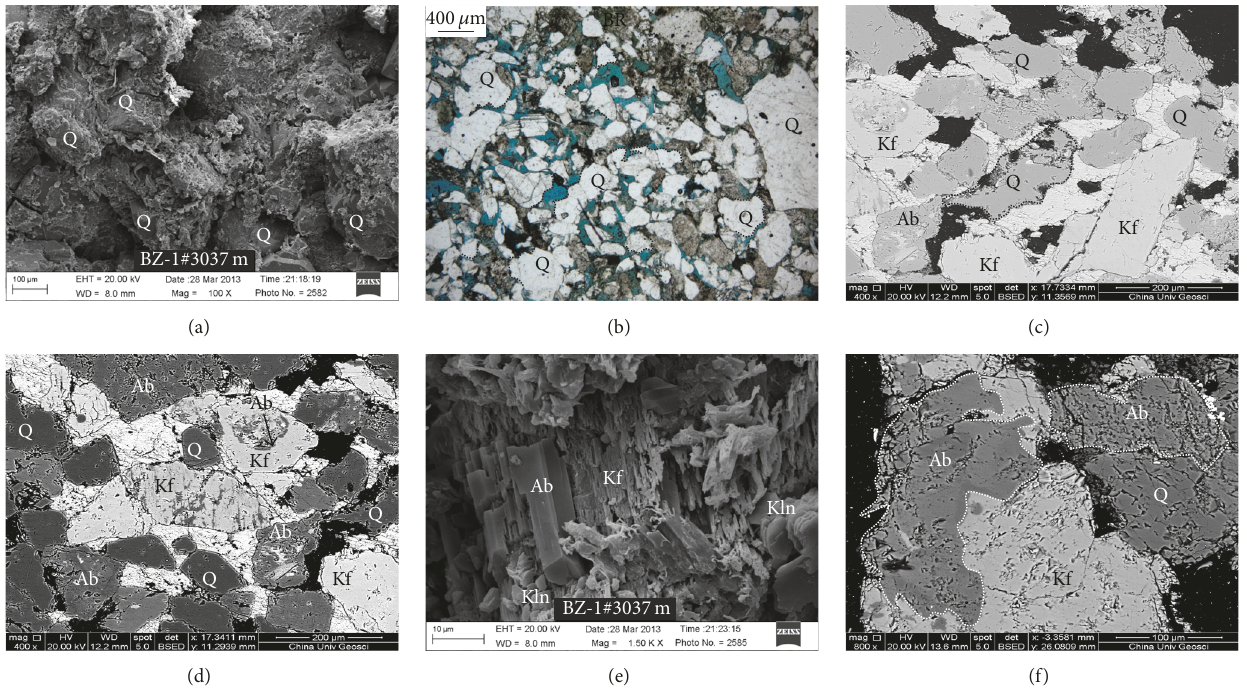
Figure 6: Photomicrographs of quartz grains dissolution and K-feldspar albitization in the Paleogene sandstone reservoirs in the well BZ- 1 of Huanghekou Sag. (a) Environmental scanning electron microscope (ESEM) image of dissolved quartz (Q), E 2 s 1 , 3037 m (9964 ft). (b) Dissolution of quartz showing embayed shape (marked with black dot line), E 2 s 1 , 3037 m (9964ft). (c) Backscattered electron (BSE) image of quartz dissolution along grain boundary and fracture, E 3 d 3 , 2944 m (9659 ft). (d) Albitization (Ab) of K-feldspar along cleavage plane, E 3 d 3 , 2944 m, BSE image (9659ft). (e) SEM photograph of albite crystals in partly dissolved K-feldspar grain, E 2 s 1 , 3037 m (9964ft). (f) K-feldspar was replaced by albite, E 2 s 1 , 3037 m (9964 ft). Ab = albitization, Kf = K-feldspar, Kln = kaolinite, and Q =